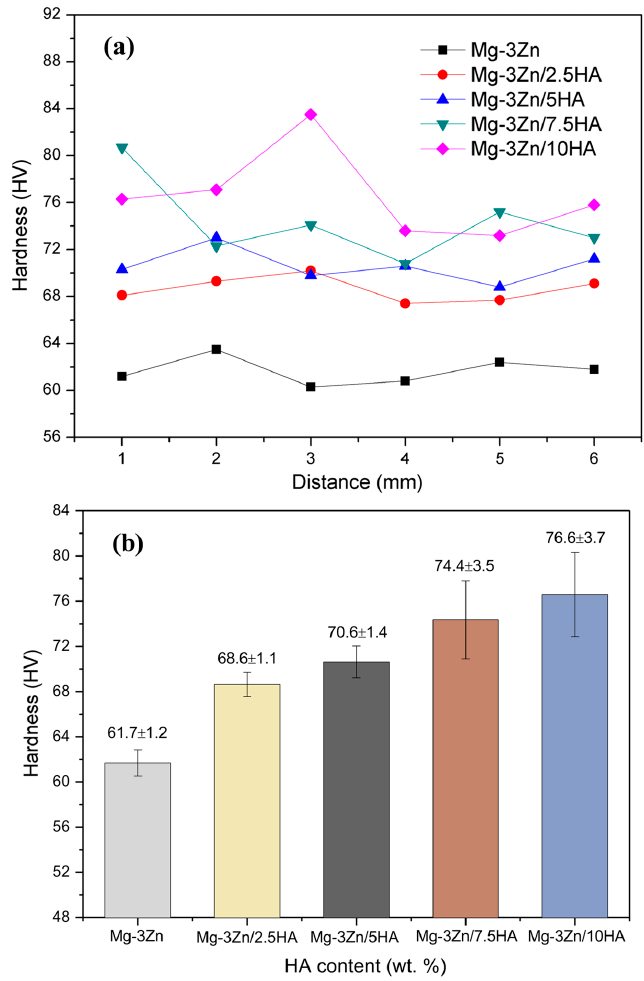
Figure 7. The hardness of the Mg-3Zn/ x HA composites: ( a ) hardness distribution and ( b ) average hardness.